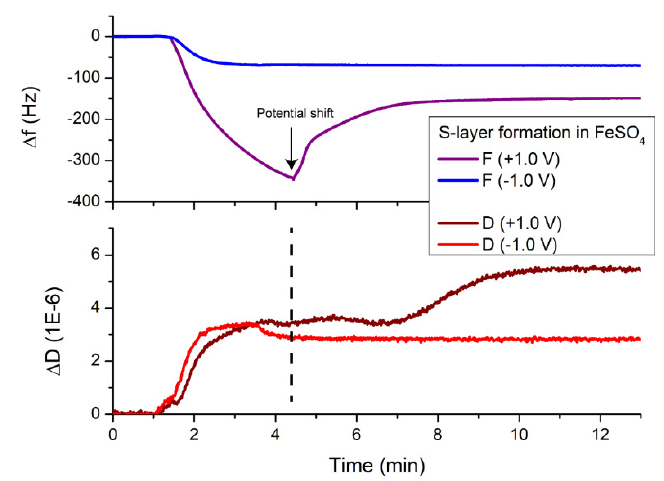
Figure A4. Real-time monitoring of SbpA adsorption onto hydrophobic gold, under two different potential values ( − 1 vs. +1 V) being applied. The black arrow indicates the moment at which the oxidative value (+1 V) the potential is changed to reducing values ( − 1 V), which completely influences the protein-substrate interaction.